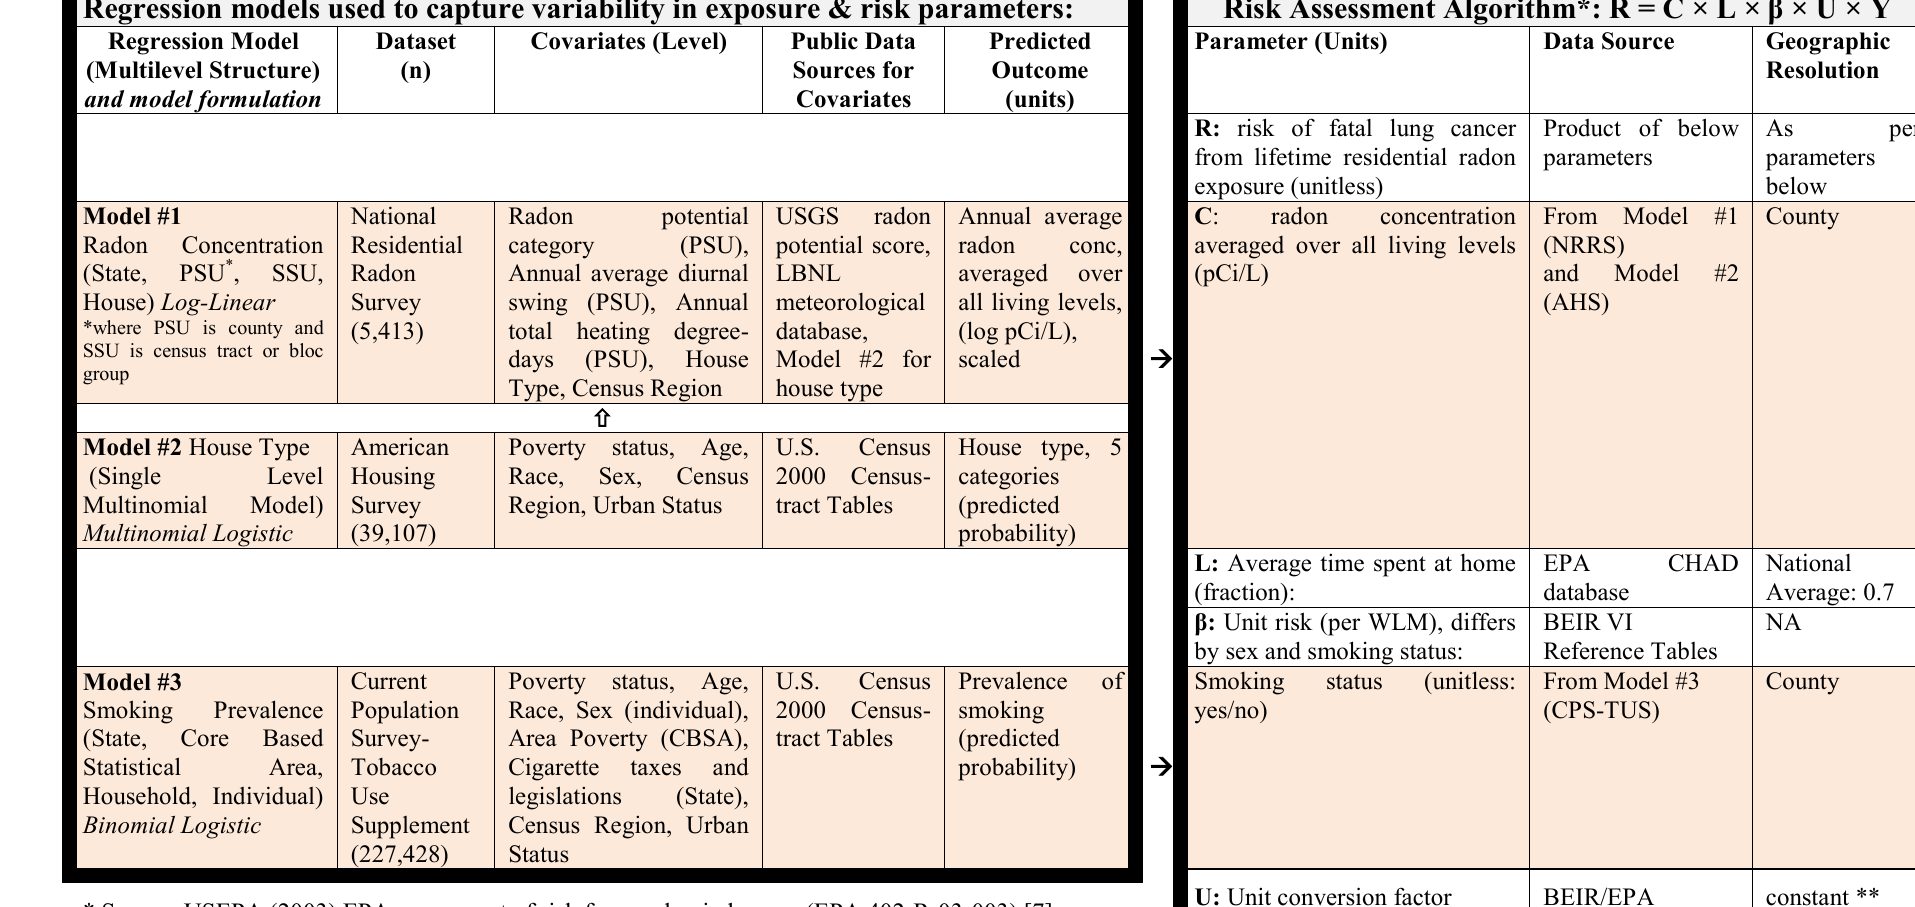
Table 1. Regression models used to capture variability in parameters of risk assessment algorithm.